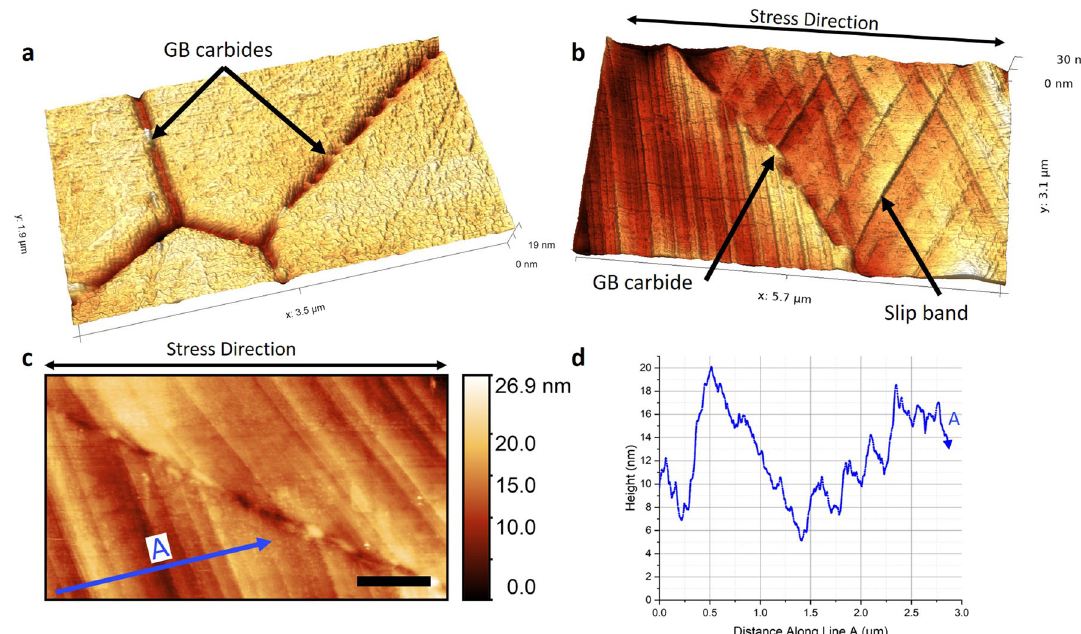
Fig. 1 Ex situ HS-AFM measurements of sensitisation and strain. Images show 3D HS-AFM topographic maps of: a GBs and GB carbide precipitates within thermally sensitised AISI Type 304 stainless steel, and ( b ) slip bands in sensitised AISI Type 304 stainless steel across a GB. Also shown is: c an HS-AFM topographic map of slip bands in sensitised AISI Type 304 stainless steel across a GB (scale bar: 1 µm), and ( d ) a line pro fi le along the line labelled A shown in ( c ) as a dark blue line, showing variation in height across dislocation steps. Height measurements have an error of ±15 pm. Additional topographic images showing measurements of strain are given in Supplementary Fig.